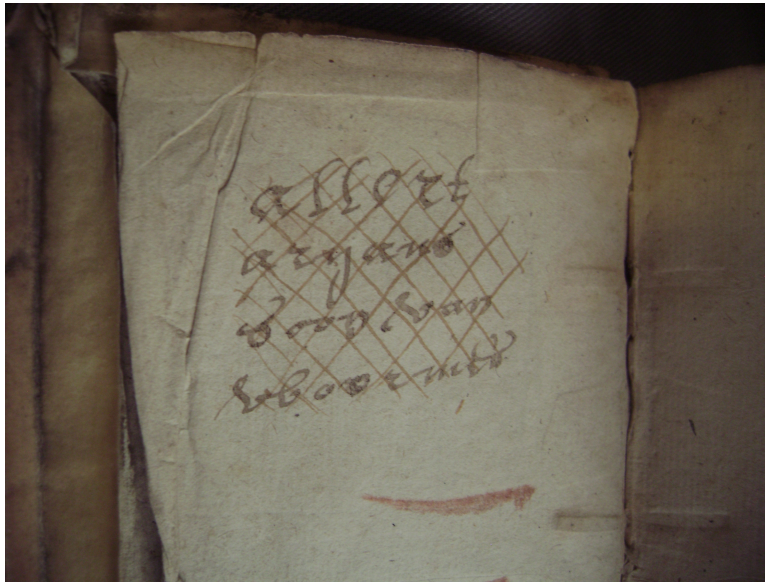
Figure 2. Owner’s inscription in the first edition of De Witte’s Wederlegginge , fly leaf, UB Leiden, shelf mark 55 H 16.